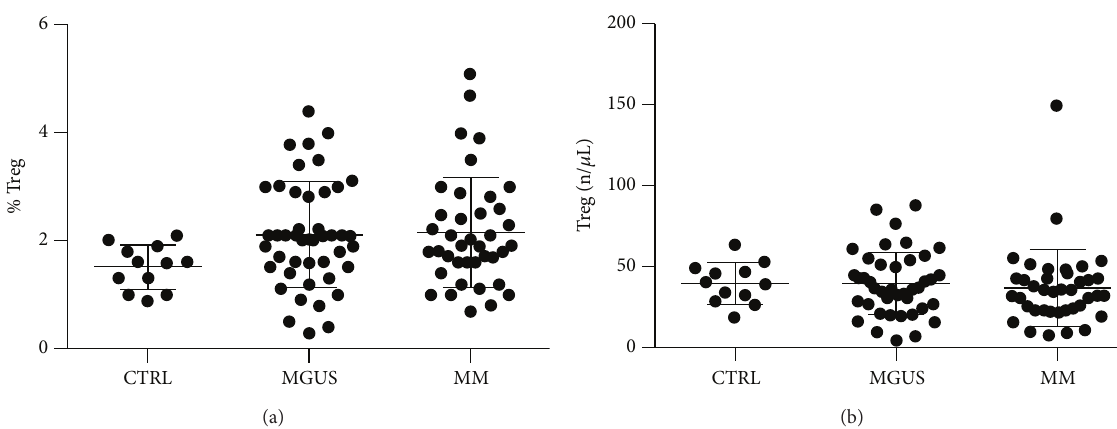
Figure 2: Circulating Tregs, detected as percentage of all lymphocytes (a) and as absolute number (b) in controls (CTRL), monoclonal gammopathy of uncertain significance (MGUS), and multiple myeloma (MM) patients, including those with smoldering MM (SMM). Horizontal bars indicate mean ( ± standard deviation) values. No statistically significant differences were found among the three groups.